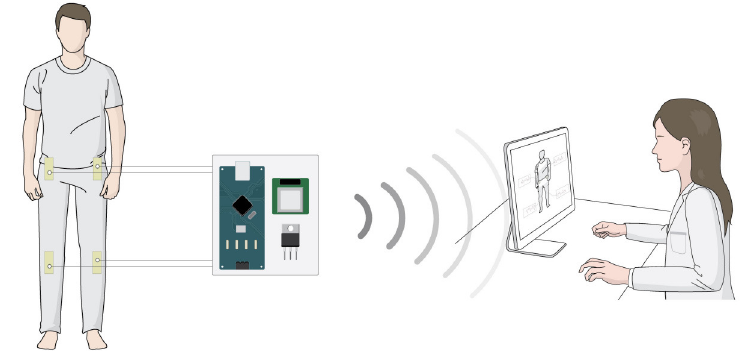
Figure 6. Experimental setup for testing the patient motion and posture monitoring